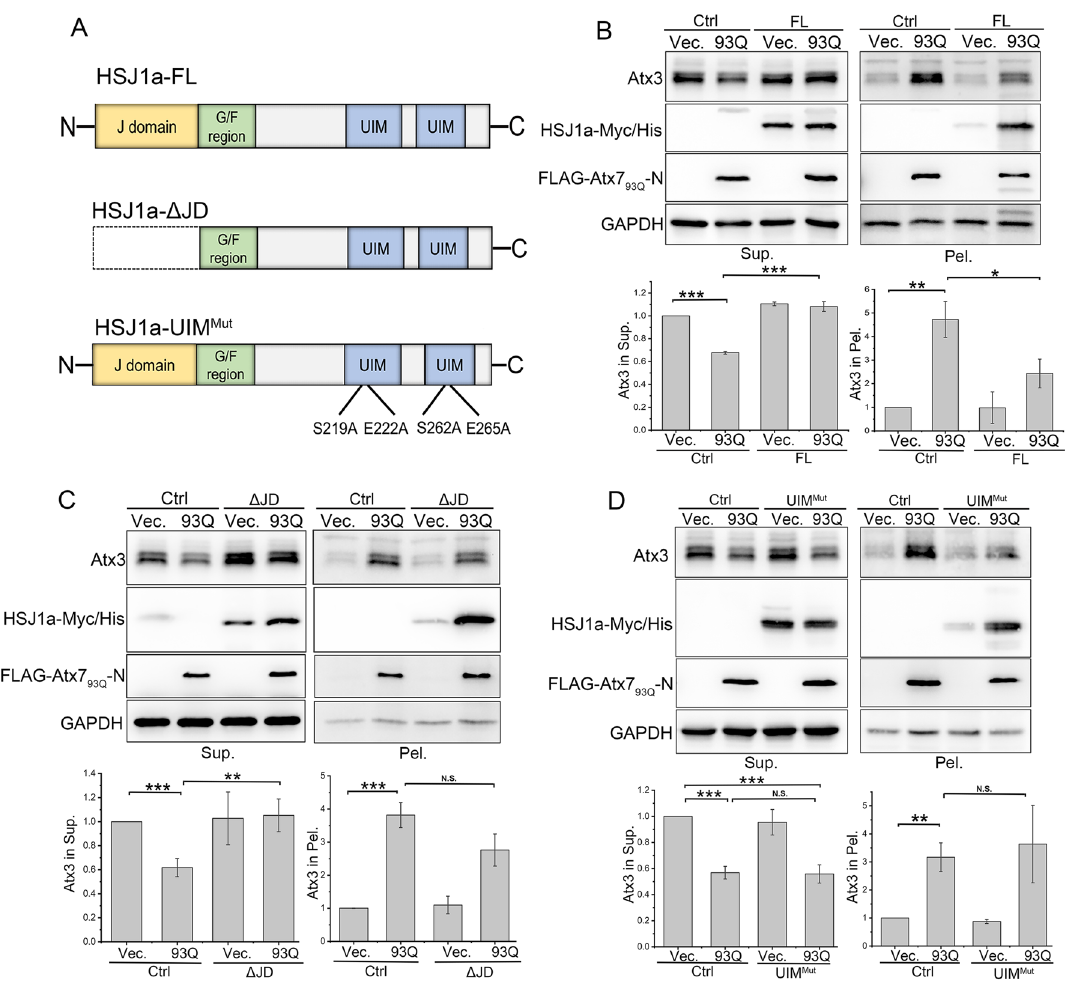
Figure 4. HSJ1a suppresses the degradation of Atx3 through its UIM domain. ( A ) Domain architectures of the HSJ1a protein and its mutants applied. ( B ) Overexpression of HSJ1a alleviates the decline of soluble Atx3 but still increases the aggregates caused by Atx7 93Q -N172. ( C ) As in ( B ), HSJ1a-ΔJD. ( D ) Overexpression of HSJ1a- UIM Mut fails to suppress the decline of soluble Atx3 caused by Atx7 93Q -N172. HSJ1a-Myc/His or its mutants (HSJ1a-ΔJD and HSJ1a-UIM Mut ) was co-expressed with Atx7 93Q -N172 in HEK 293T cells. The pcDNA3.1- Myc/His plasmid was set as a control (Ctrl). The cell lysates were subjected to supernatant/pellet fractionation and Western blotting. Indicated proteins were detected by using anti-FLAG, anti-Myc, anti-Atx3 and anti- GAPDH antibodies. Sup., supernatant; Pel., pellet. Data are shown as Means ± SEM (n = 3). * p < 0.05; ** p < 0.01; *** p < 0.001; N.S., no